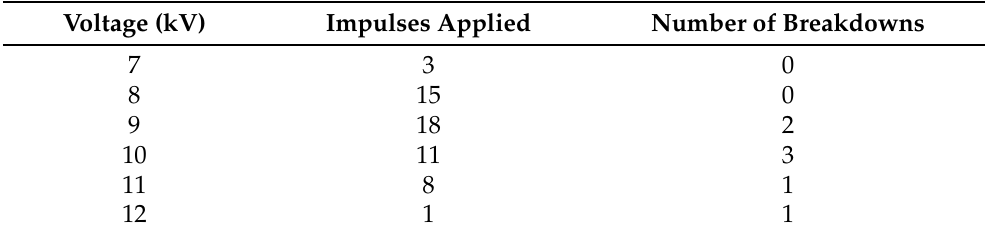
Table 5. Impulse test applied with and without breakdown for MO-impregnated samples.